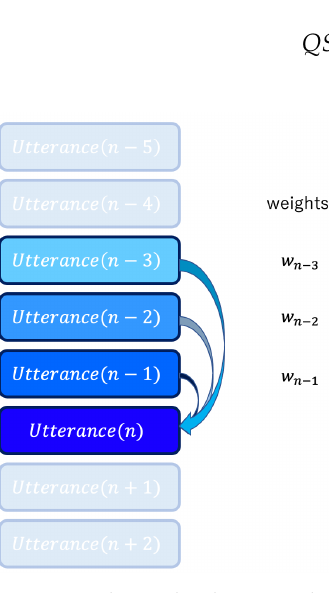
Figure 3. Relationship between the n th utterance and the previous